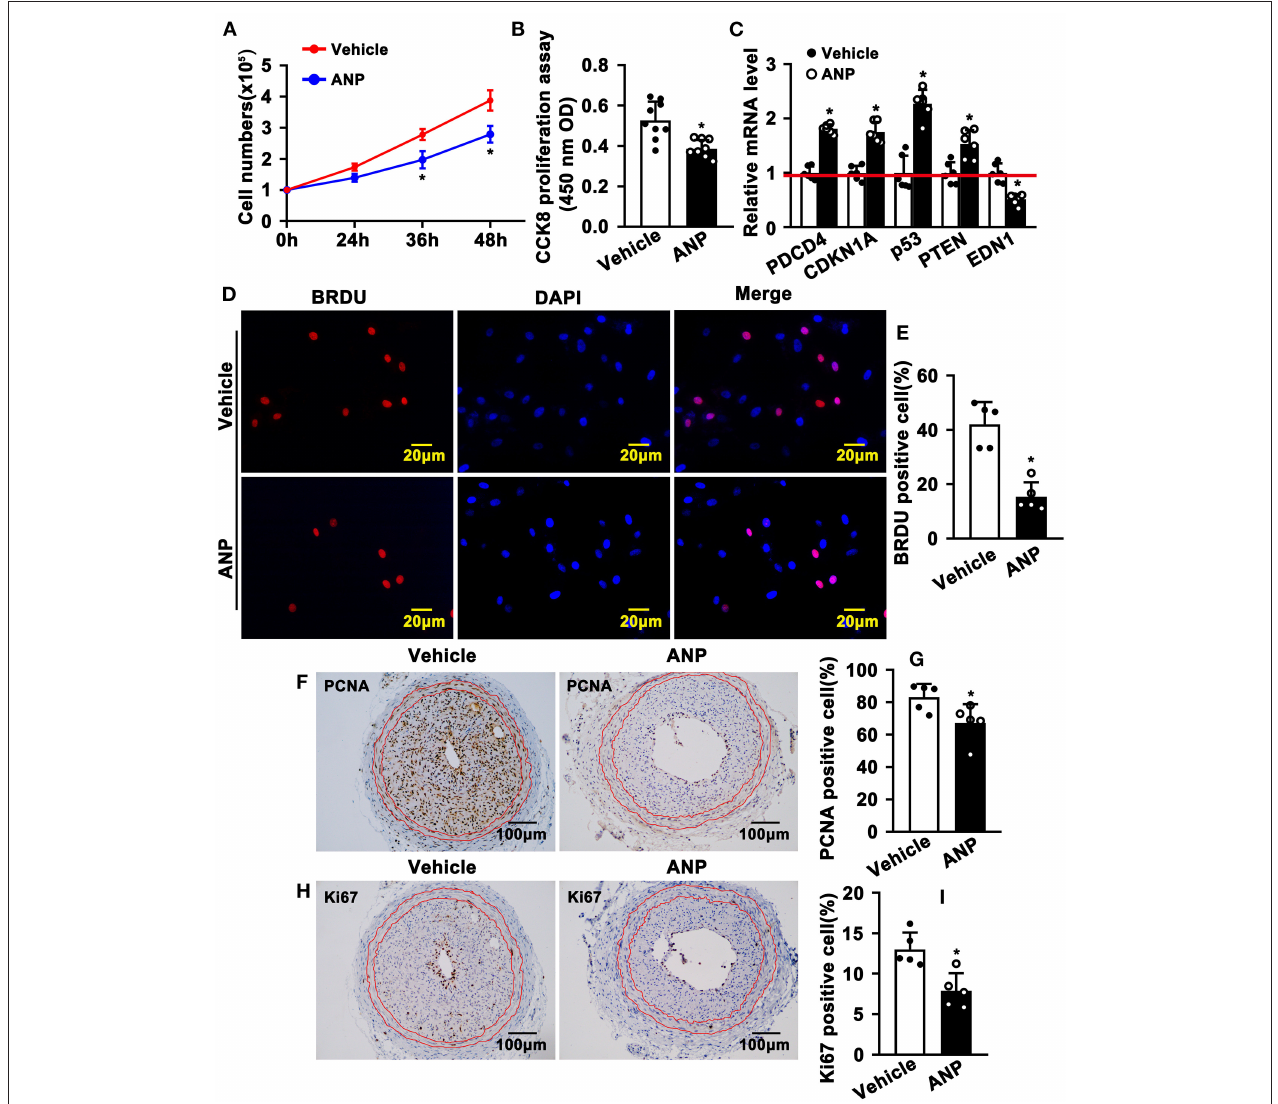
FIGURE 3 | Andrographolide inhibits proliferation of vascular smooth muscle cells. (A) Rat SMCs were treated with Andrographolide (5 µ M), and the cell numbers were counted at different time points ( n = 6). (B) Cell viability was detected by a CCK8 cell proliferation assay ( n = 8). (C) The mRNA levels of proliferation-related genes were detected by real-time PCR ( n = 6). (D) Rat SMCs were incubated with BRDU labeling buffer for 20h, following Andrographolide treatment overnight. Immunofluorescence staining was performed to evaluate BRDU incorporation and BRDU-positive cells shown in (E) . (F,H) Immunohistochemical staining was performed against proliferation marker genes PCNA and Ki67 on the left common carotid artery complete ligation model. PCNA and Ki67-positive SMCs in neointimal areas are shown in (G,I) ( n = 5). The analysis data are expressed as means ± SEM. * P <